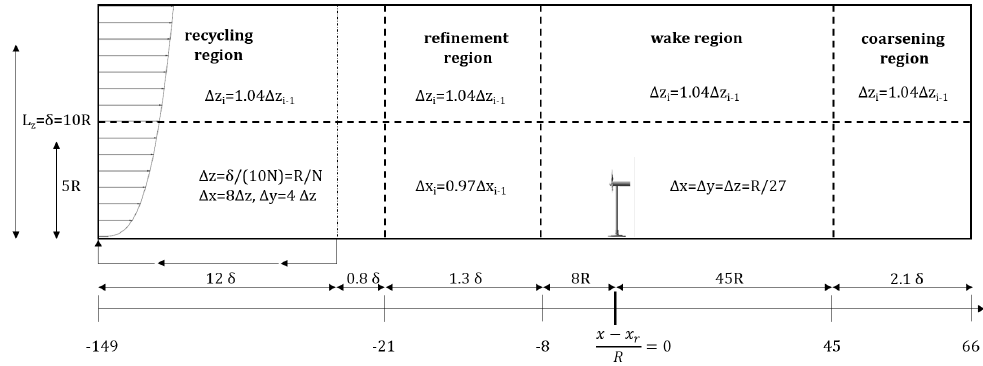
Figure 6. Sketch of the computational domain used in the LES of the model wind